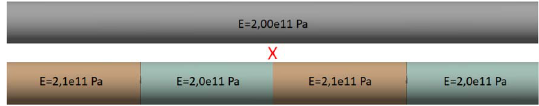
Figure 13. Comparison performed between the symmetrical tube and the tube with different modulus of elasticity in longitudinal sections.